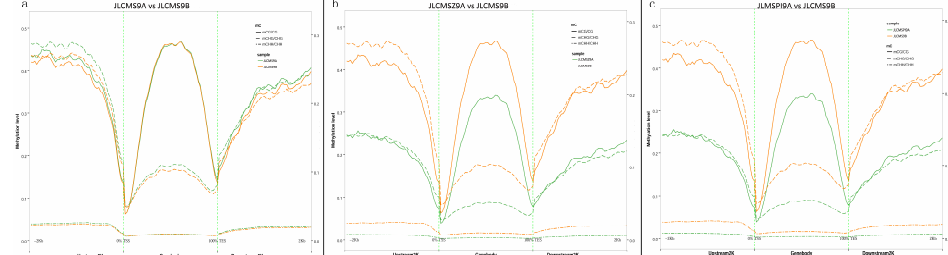
Figure 1. Distribution of methylated cytosines in the gene bodies and respective the 2-Kb upstream and 2-Kb downstream sequences among four soybean genomes. Different gene regions (X-axis), the upstream2K, genebodies, and downstream2K regions, were divided into 50 bins, and the methylation levels of all regions were respectively averaged. The methylation levels are shown on a CG sequence environment methylation level scale (right Y-axis coordinate) and on a non-CG sequence environment scale (left Y-axis coordinate). ( a ) JLCMS9A vs JLCMS9B; ( b ) JLCMSZ9A vs JLCMS9B; ( c ) JLCMS9A vs JLCMS9B.